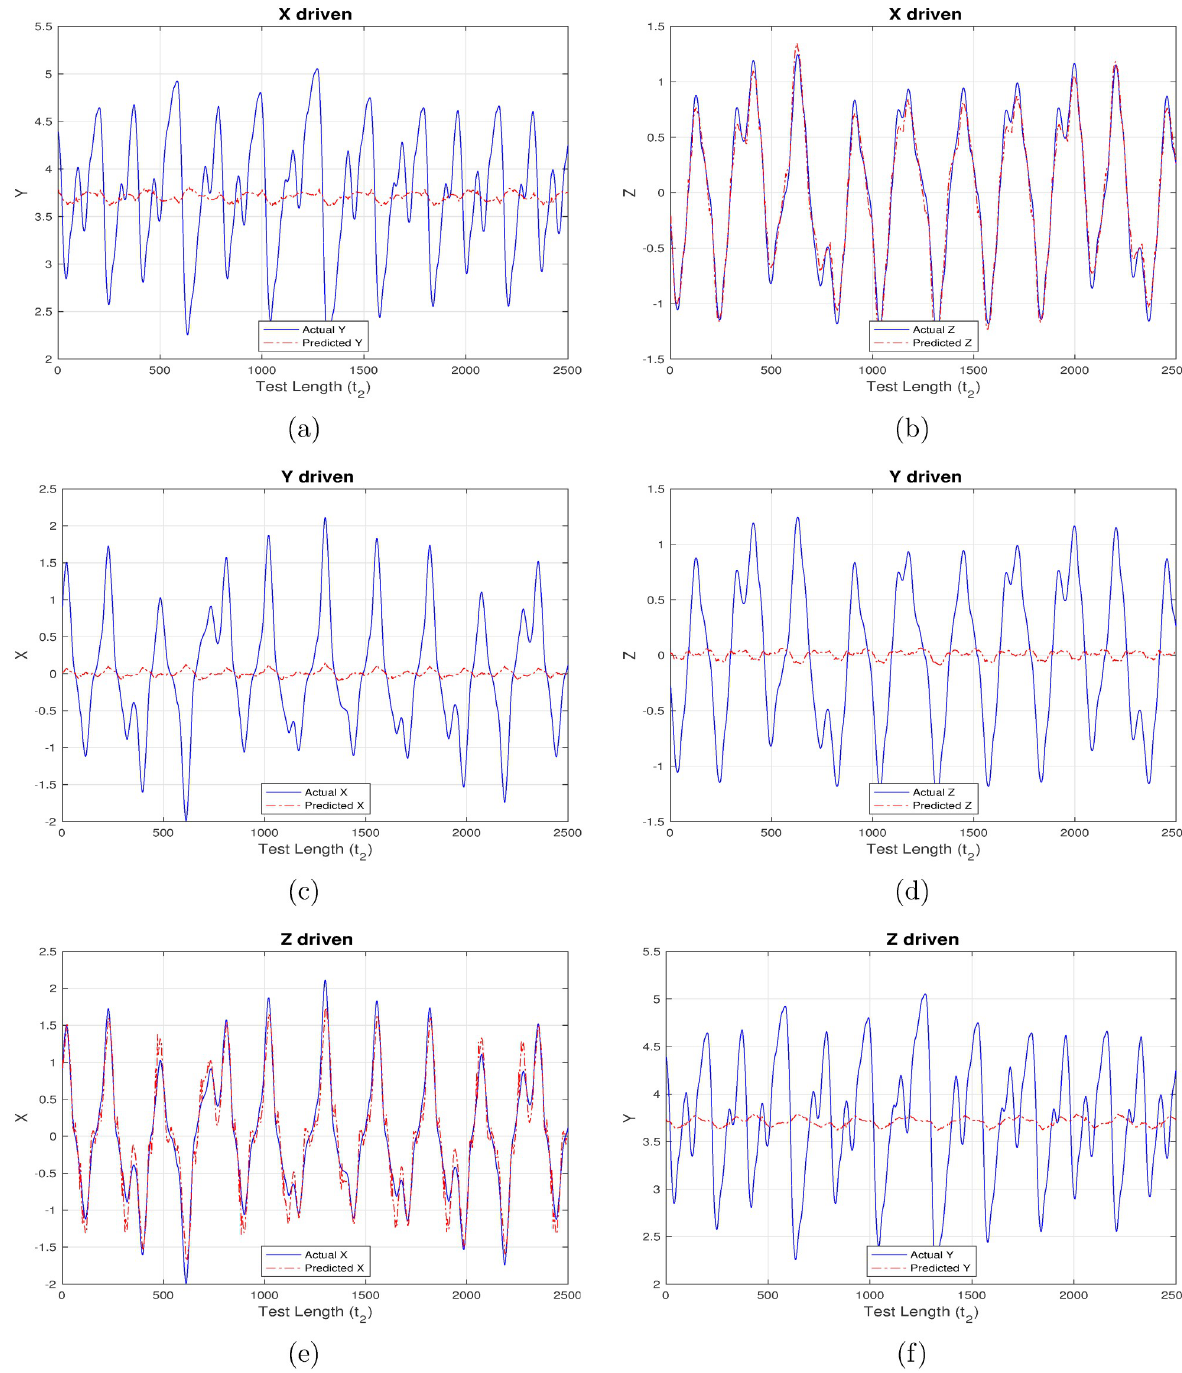
Fig 4. Chaotic financial system component re-generation using “linear” activation. (a) Re-generating “investment demand” [Y] behavior with “interest rate” [X] as input (b) Re-generating “price index” [Z] behavior with “interest rate” [X] as input (c) Re-generating “interest rate”[X] behavior with “investment demand”[Y] as input (d) Re-generating “price index” [Z] behavior with “investment demand” [Y] as input (e) Re-generating “interest rate” [X] behavior with “price index” [Z] as input (f) Re-generating “investment demand” [Y] behavior with “price index” [Z] as input.